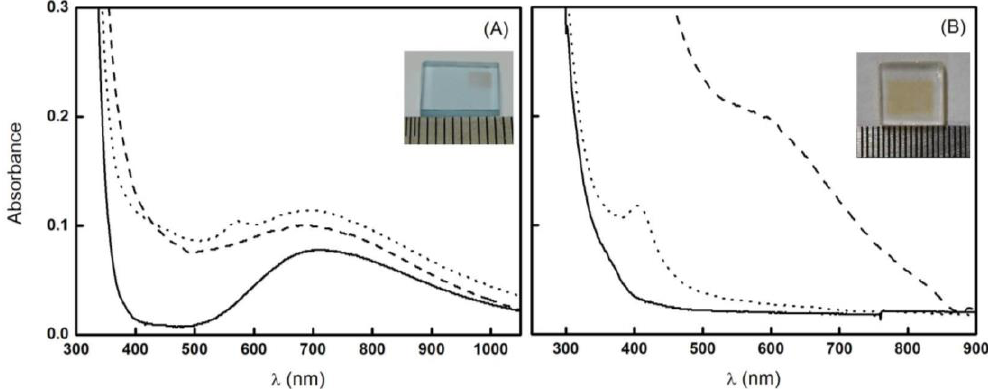
Figure 12. Absorption spectra of ( A ) copper-doped borosilicate glass and ( B ) silver-doped bariumborate glass. Solid lines represent the glasses as prepared, while dotted and dashed lines are the spectra after the irradiation with fs-lasers of 5 MHz and 1 kHz repetition rate respectively. Surface plasmon resonances of Cu 0 and Ag 0 nanoparticles are seen, respectively, at ( A ) 570 nm and ( B ) 410 nm. The insets show the sample picture containing the NPs. Reprinted with permission from [107,109]. Copyright (2012), OSA (for figure ( A )) and Copyright (2013), Elsevier (for figure ( B )).